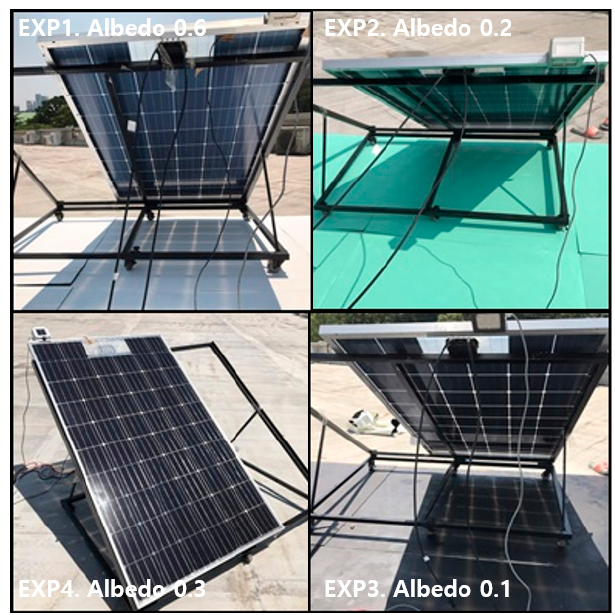
Figure 6. Output parameters of the module used under Standard Test Condition ( STC ).